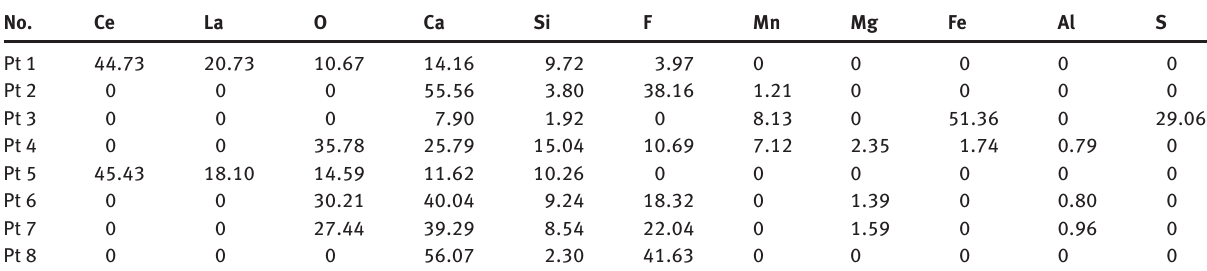
Table 3: EDS analysis data of the composition of the parallel sample and the separation products (mass fraction, %) No. Ce La O Ca